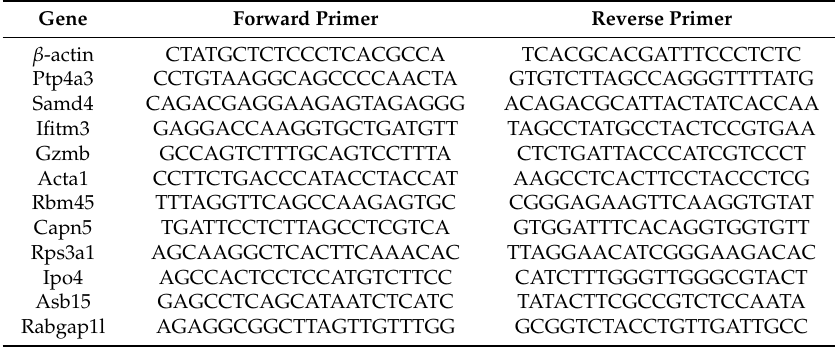
Table 2. PCR primer sequences of HIF-1 α target